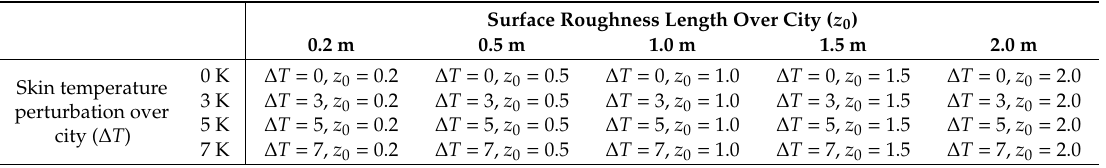
Table 1. Summary of the experiments within the parameter space. All experiments are identical except for two parameters: The surface roughness length ( z 0 ) within the idealized city and the skin temperature perturbation (relative to the surrounding area) within the city ( ∆ T